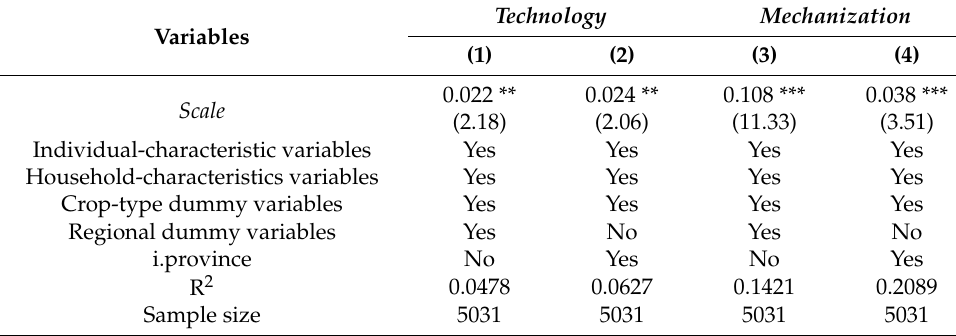
Table 4. The results of the mechanism test.